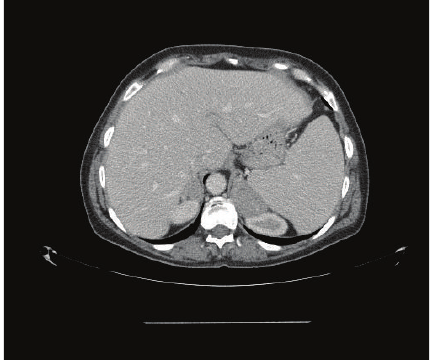
Figure 1: CT of the abdomen showing bilateral, homogenous adrenal gland